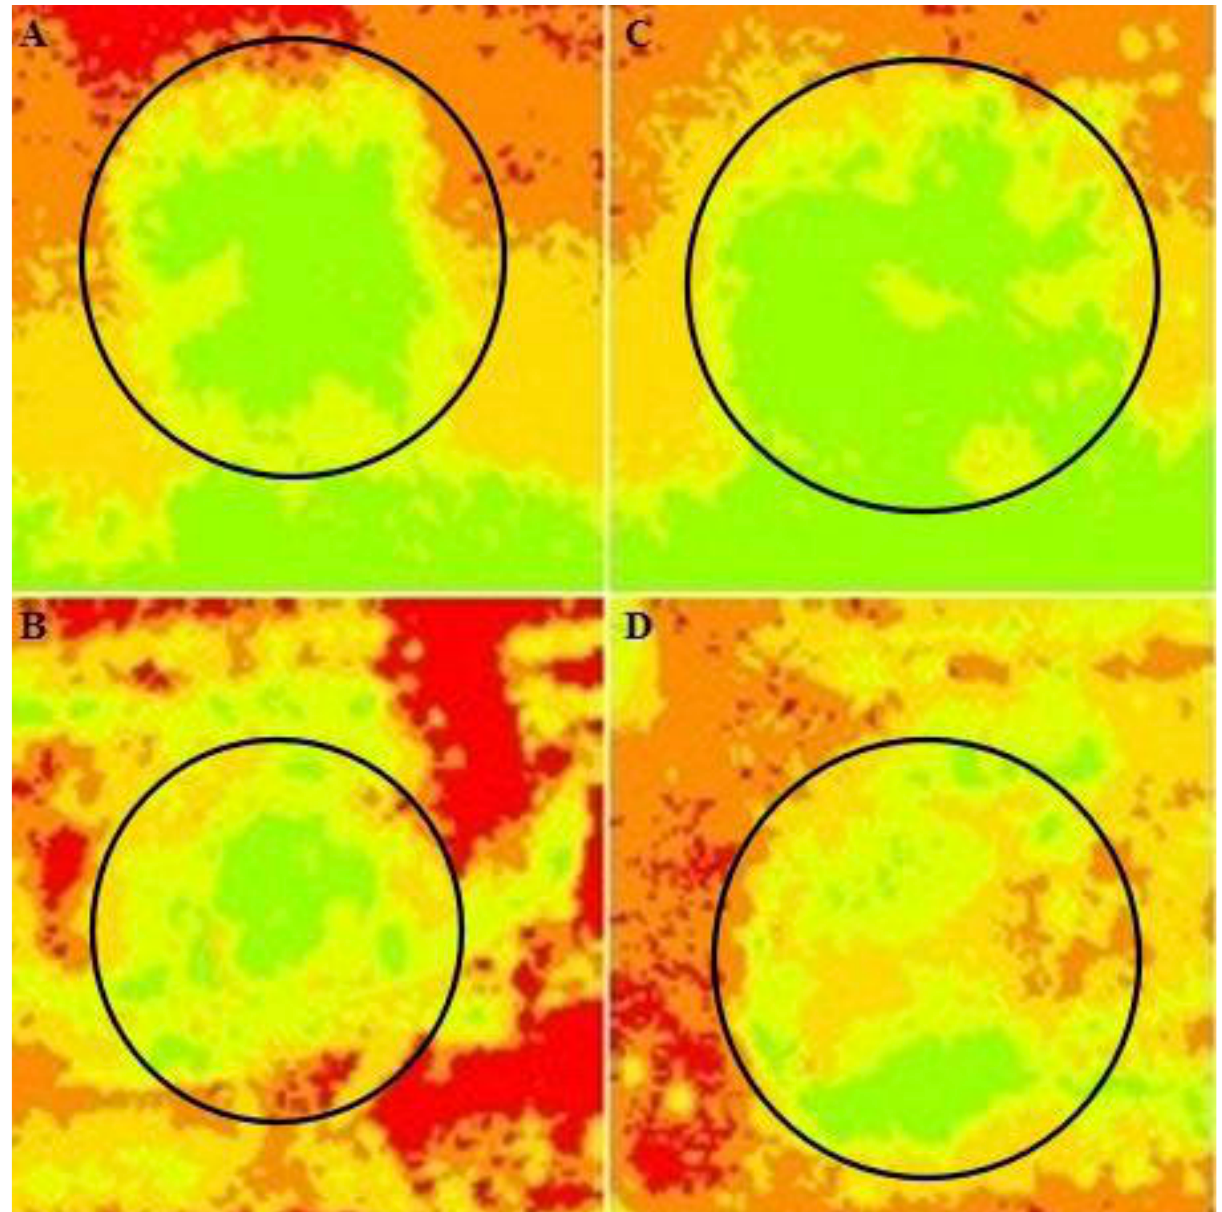
Figure 8. Olive tree patterns (within circle) obtained through the normalized difference vegetation (NDVI) index assessed on 9 October, 2017, at the end of the trial performed in the orchard of Veglie (Lecce province). A: cv. Ogliarola salentina tree treated with Dentamet®. B: cv. Ogliarola salentina untreated control tree. C: cv. Cellina di Nardò tree treated with Den - tamet®. D: cv. Cellina di Nardò untreated control tree. Green: indicates the vegetation as revealed by the drone measure - ment; red: is the soil surface. Note that for A and C patterns (treated trees), the intensity of the green colour (NDVI) of the olive canopies is similar to that of Cupressus arizonica var. stricta trees growing closeby.The same olive trees were assessed using quantitative real-time PCR analyses to determine Xylella fastidiosa